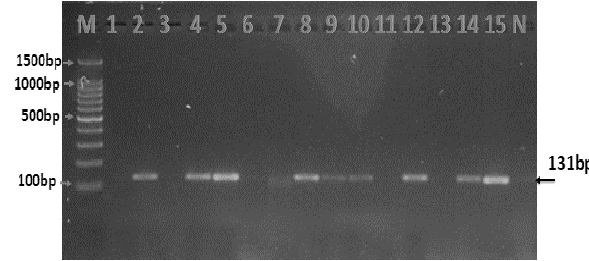
Figure 2. Agarose gel electrophoresis image shows the nested-PCR product analysis of the B1 gene of Toxoplasma gondii from milk samples. Where M: